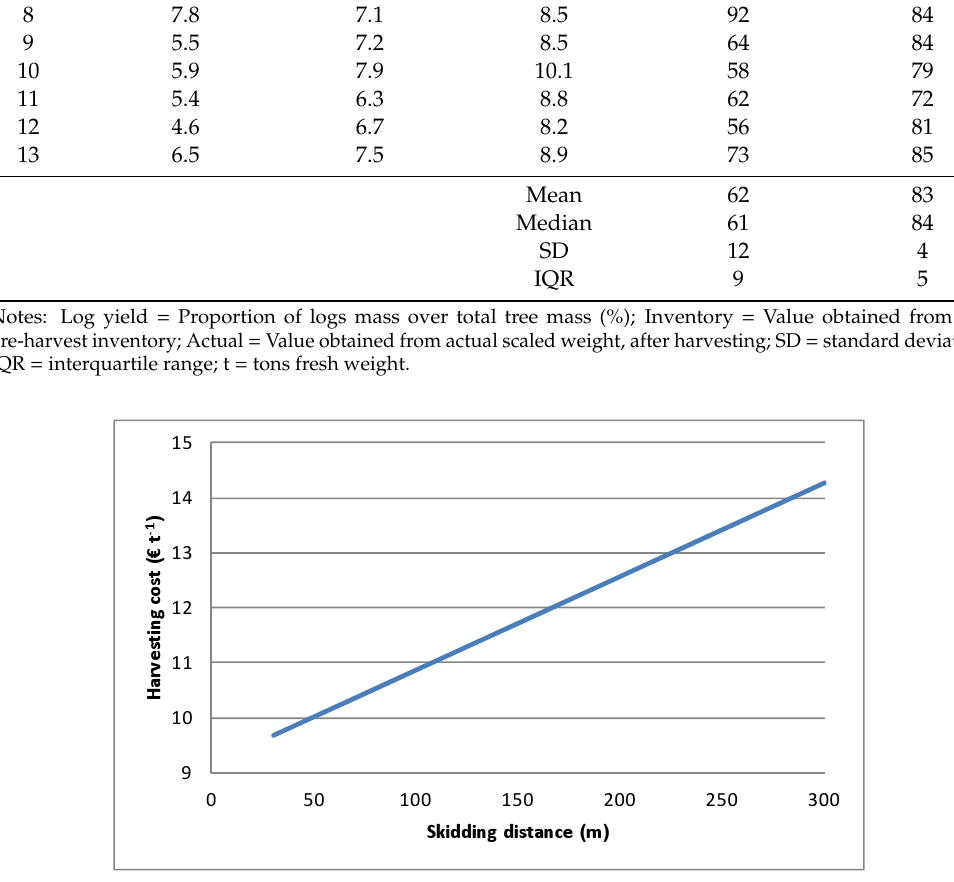
Figure 4. Harvesting cost as a function of skidding distance.